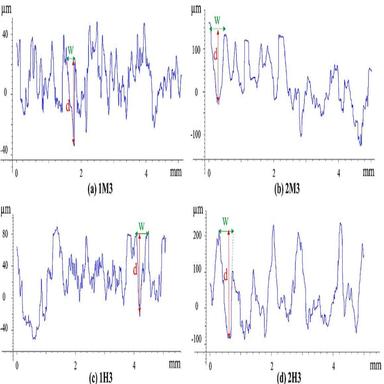
Examples of line scan profiles at H3 zones for measurements of mean crater width and depth.